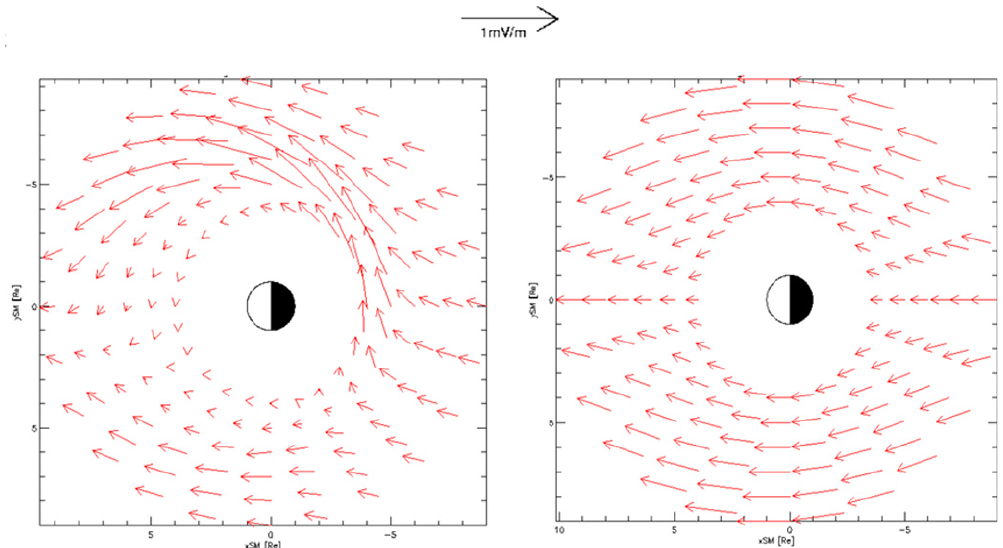
Fig. 5. Plasma convection direction with the electric field given by the McIlwain model (on the left) and the Maynard and Chen one (on the right): corotation electric field is not included in these two